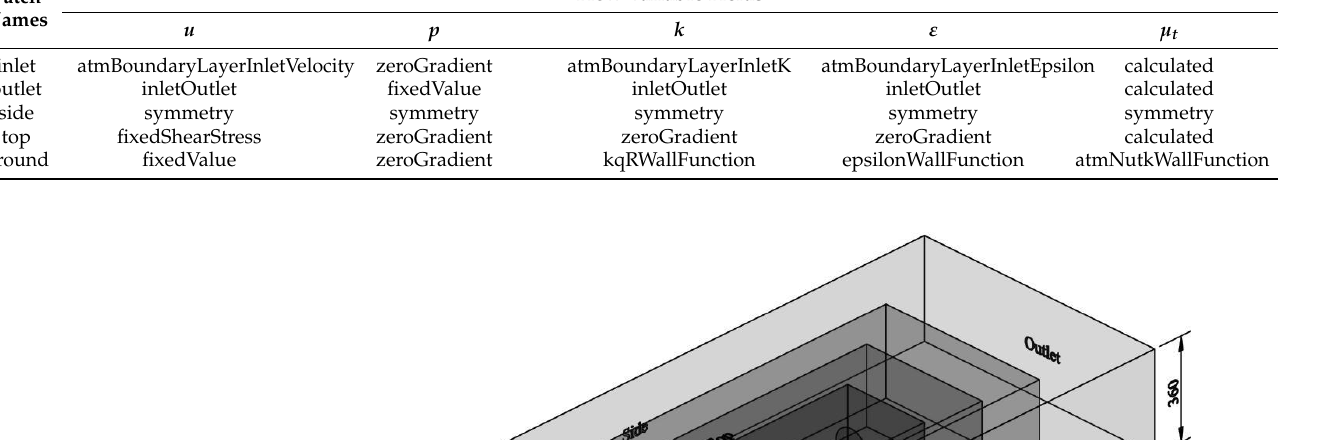
Table 2. Boundary conditions employed for the computational domain: the names of the boundary conditions are listed in accordance with the boundary condition notation in OpenFOAM.